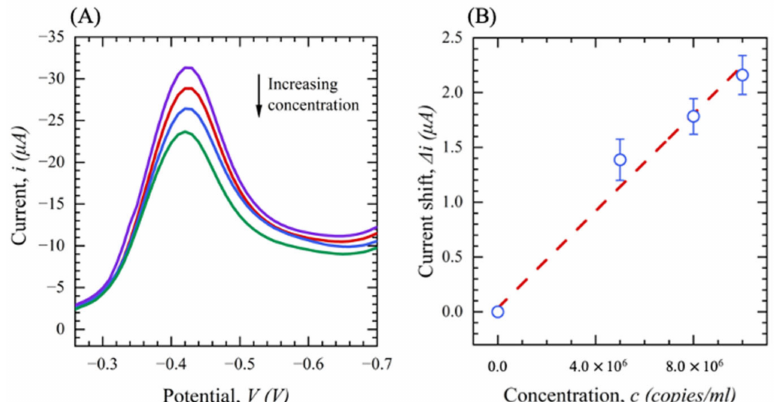
Figure 15. ( A ) SWV of SARS-CoV-2 pseudovirus; (purple: DMEM + FBS (no PV), red: 5 × 10 6 , blue: 8 × 10 6 green: 10 7 copies/mL). ( B ) The current shift ( ∆ i ) as a function of PV concentration in DMEM+10 %FBS ( n = 3).